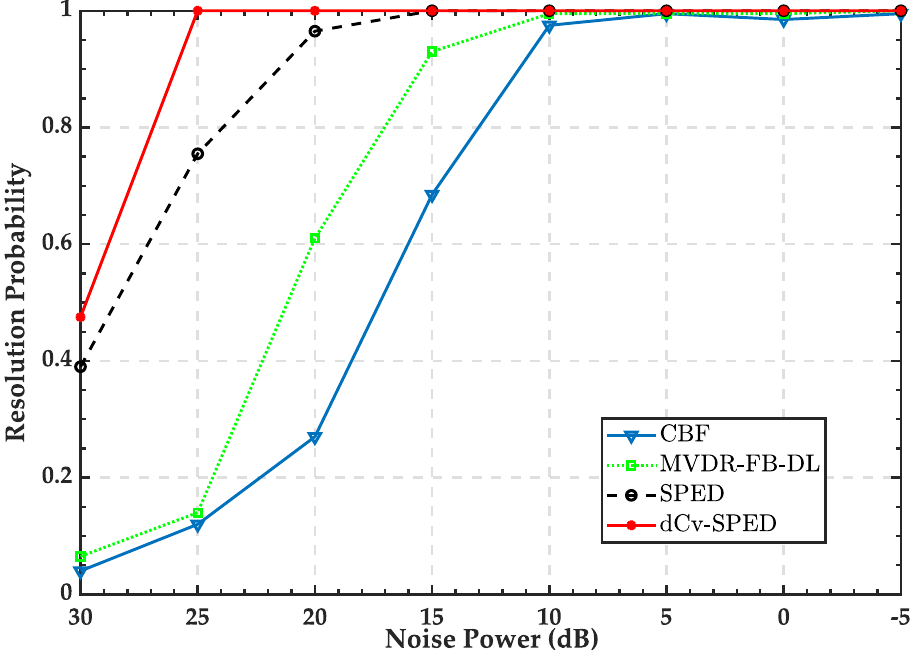
Figure 4. Resolution probability vs. noise power for the CBF, SPED, MVDR-FB-FL, and dCv-SPED.